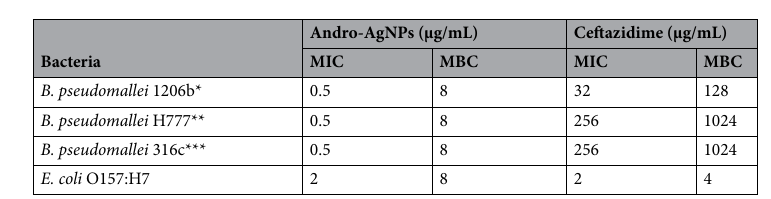
Table 1. The minimum inhibitory concentration (MIC) and minimum bactericidal concentration (MBC) of antimicrobial agents (andro-AgNPs and ceftazidime antibiotic) against three clinical isolates of B. pseudomallei and E. coli O157:H7. The experiments were performed by resazurin colorimetric assay and plate count. Data represent three independent experiments in triplicate. *CAZ non-resistant isolates. **CAZ moderately resistant isolates. ***CAZ highly resistant